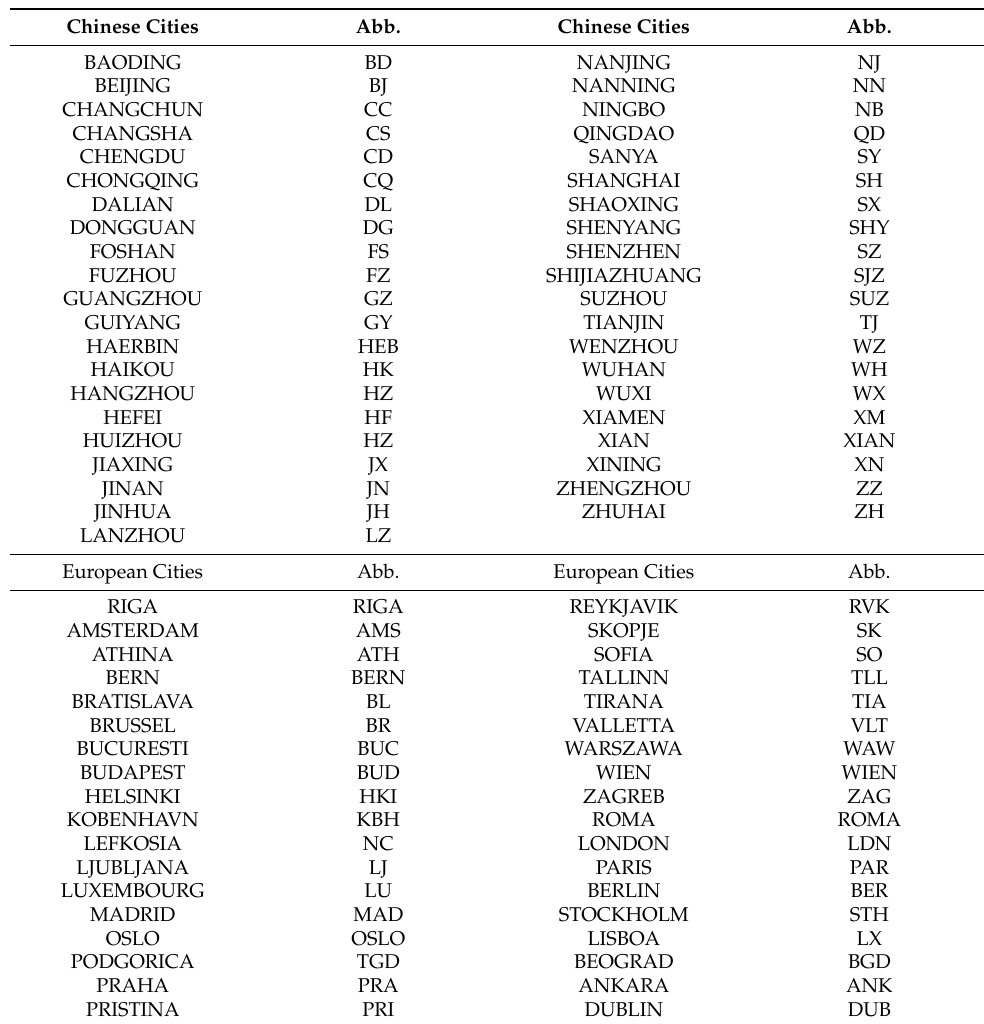
Table A1. Selected cities in China and